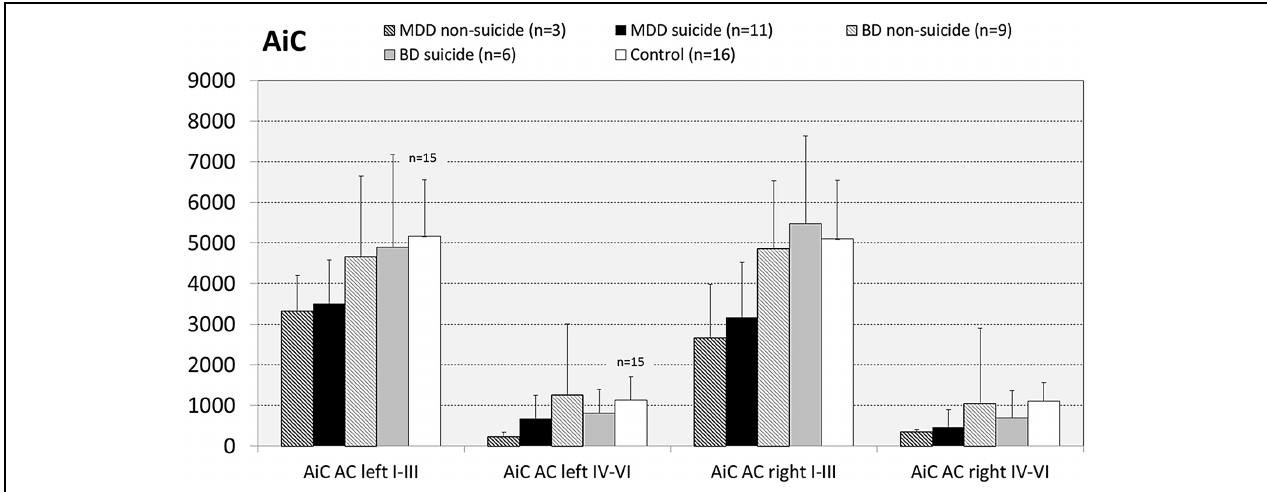
FIGURE 7 | Numerical densities of GS-expressing glial cells in the AiC of suicide completers with MDD, non-suicide completers with MDD, suicide completers with BD, non-suicide completers with BD, and controls. No significant alterations were